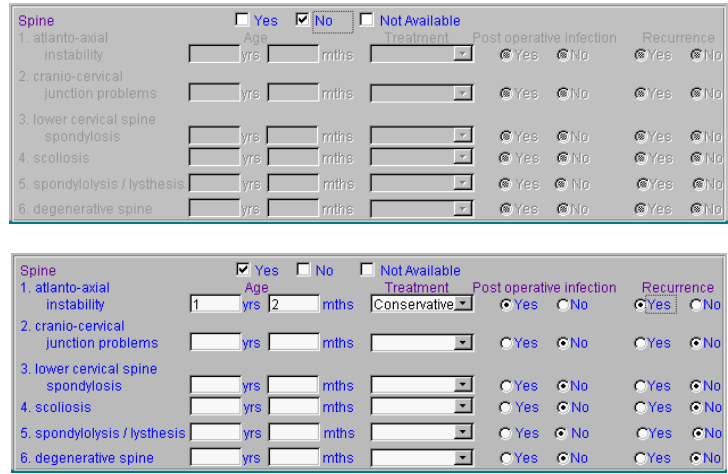
FIGURE 5. Implementation of conditional items in the form for spinal problems. In the form shown on the top, the box for no problems has been checked and the detailed questions on spinal problems are dimmed. Checking the Yes box, as in the form on the bottom, lights up the questions, prompting the physician for